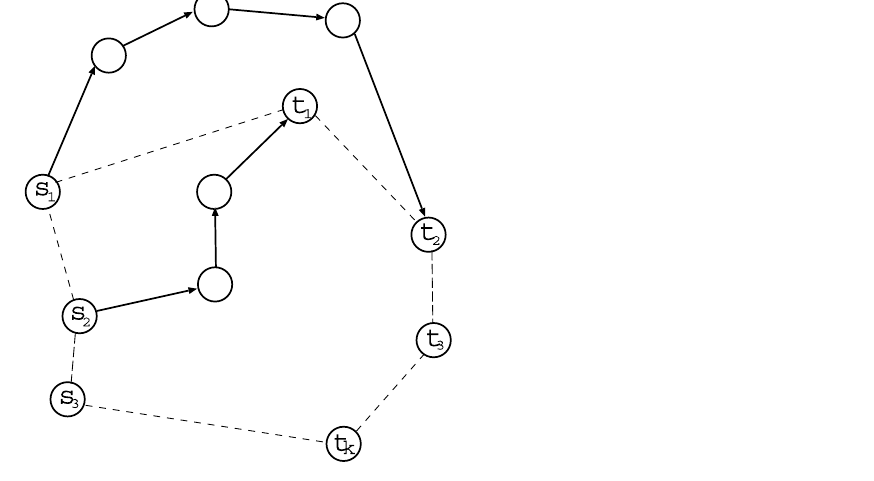
Figure 6. Example of an exceptional case. Solid lines are paths. Dashed virtual lines form a